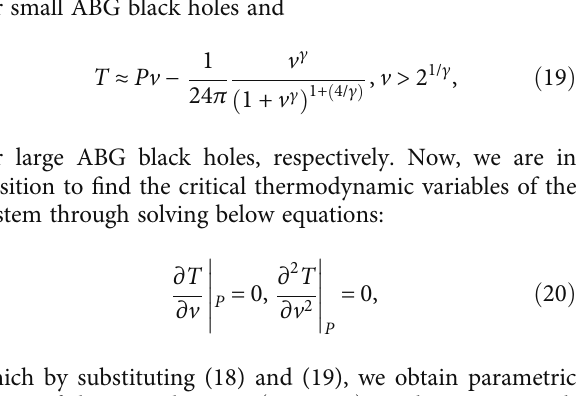
and small v − c c